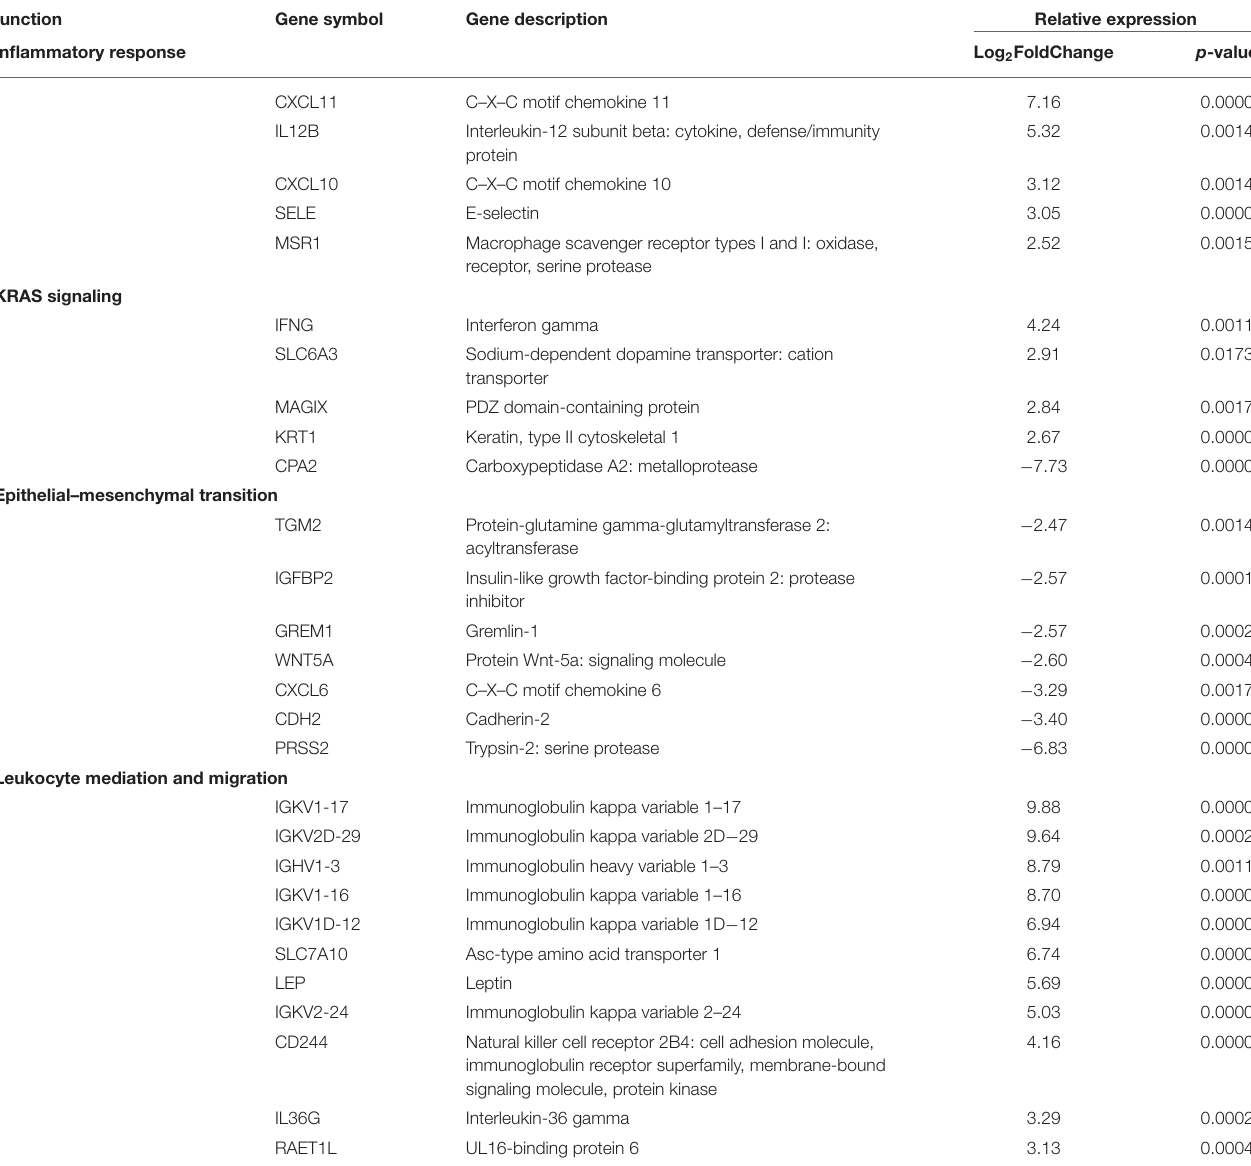
TABLE 3 | Pediatric localized scleroderma vs. healthy control comparison identifies gene enrichment groups of interest relating to inflammatory and regulatory signatures.